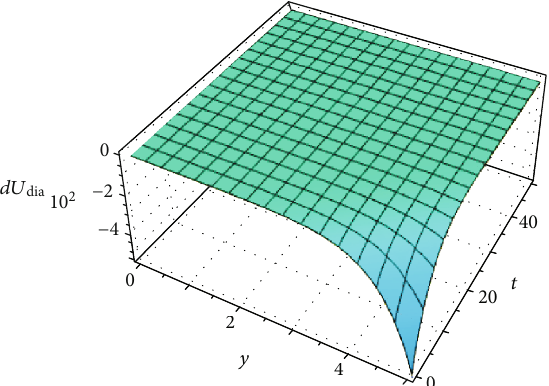
Figure 11: The internal energy change dU